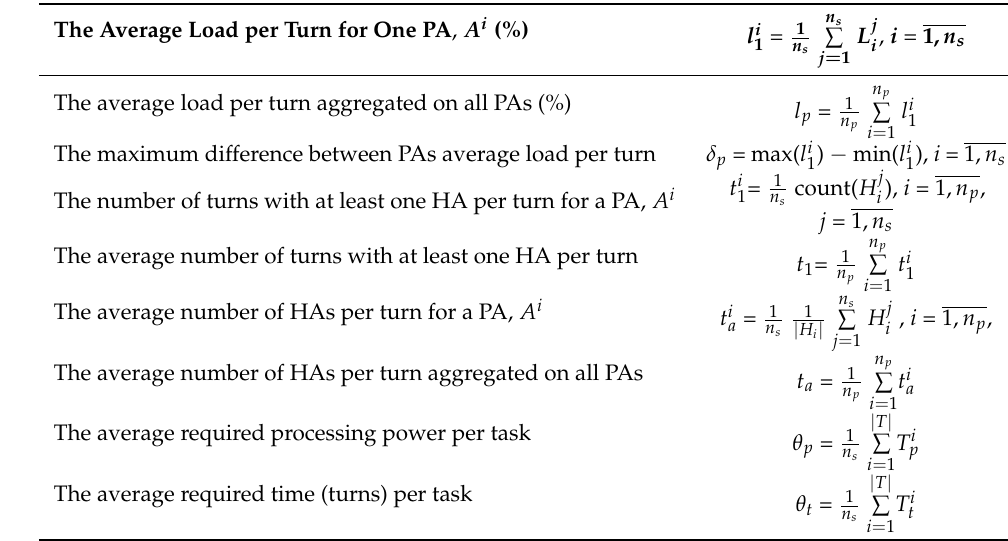
Table 2. Computed metrics: parameters and their